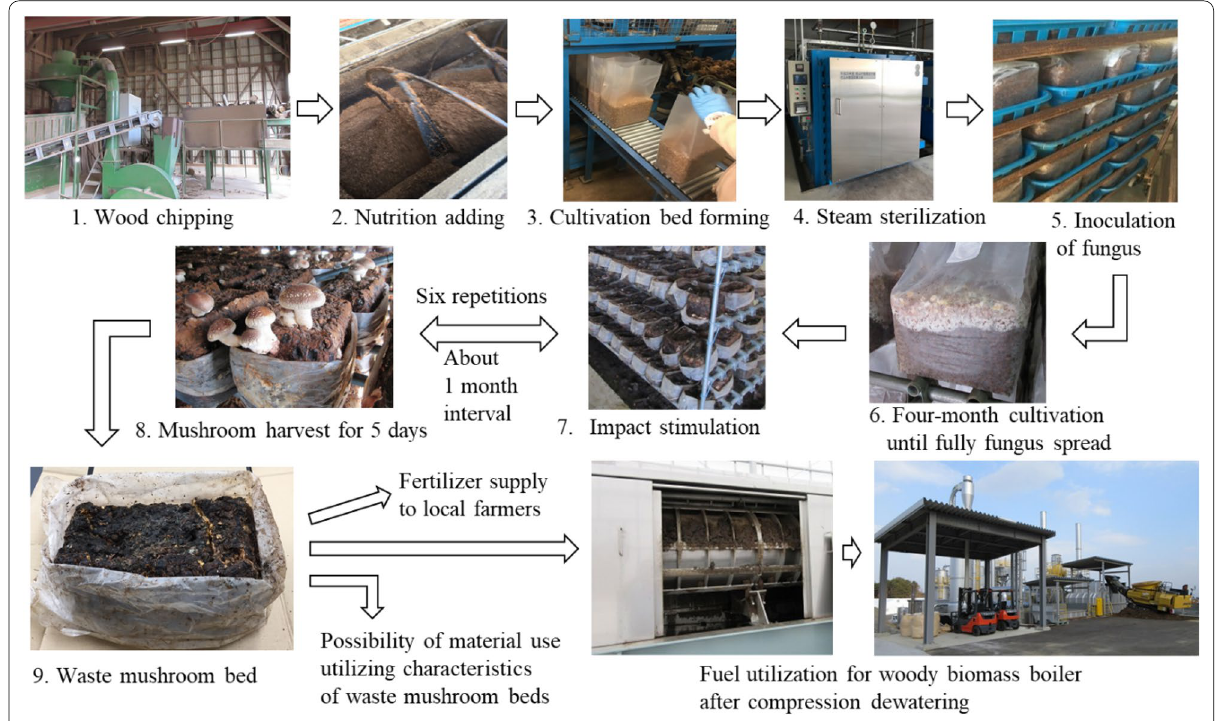
Fig. 1 Production process of shiitake mushroom using hardwood chip cultivation